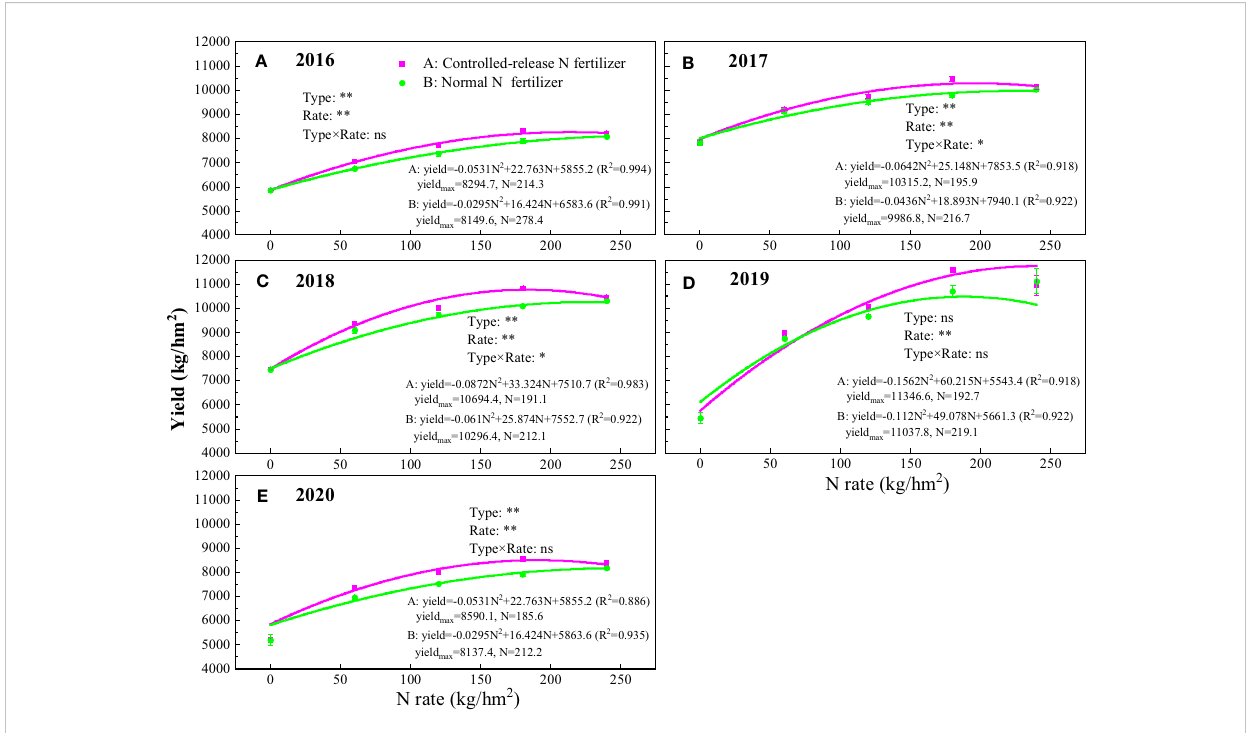
FIGURE 4 Rice yield under the blended CRN treatments (red square) and conventional N fertilizer treatments (green circle) with applied N rates of 0, 60, 120, 180, and 240 kg/hm 2 from 2016 to 2020 (A – E) . Statistically signi fi cant differences (**P<0.01; *P<0.05) and no signi fi cant differences (P >0.05, ns) are shown. Values are the means ± SEs (n =